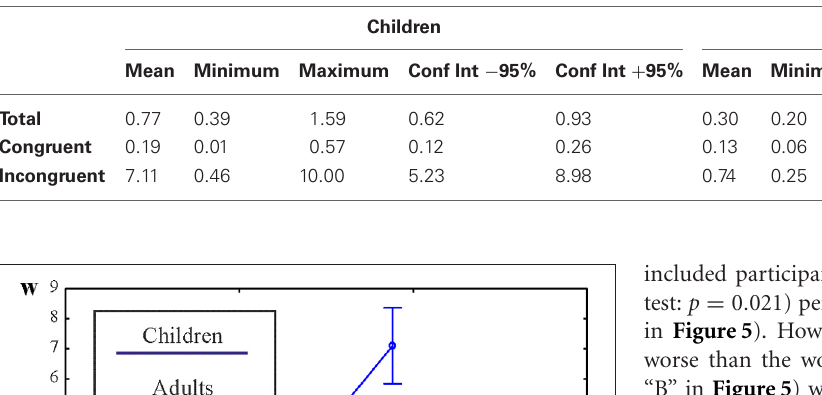
Table 1 | W -values in children and adults.